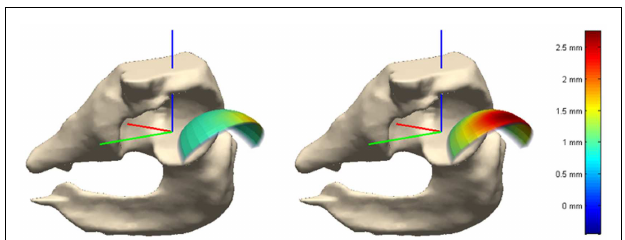
FIGURE 3 | Cartilage thickness map on weight-bearing area in normal (left) and dysplastic (right) populations .The weight-bearing area is moved out of the joint for better visualization.